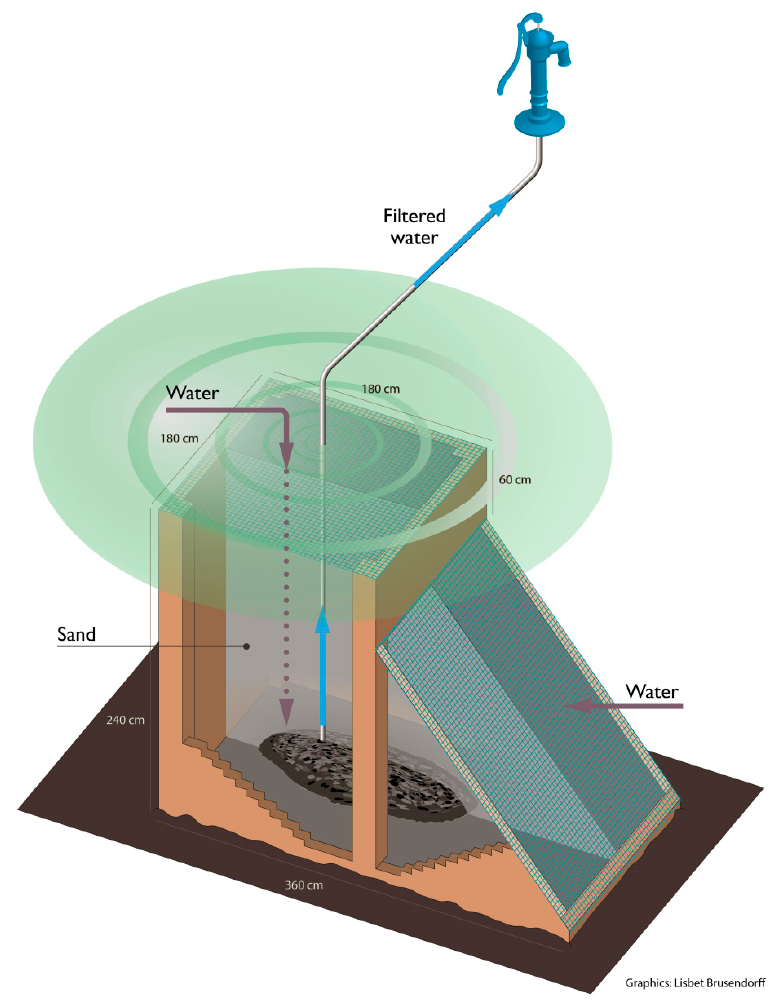
Figure 1. Constructional design of Submerged Pond Sand Filter.